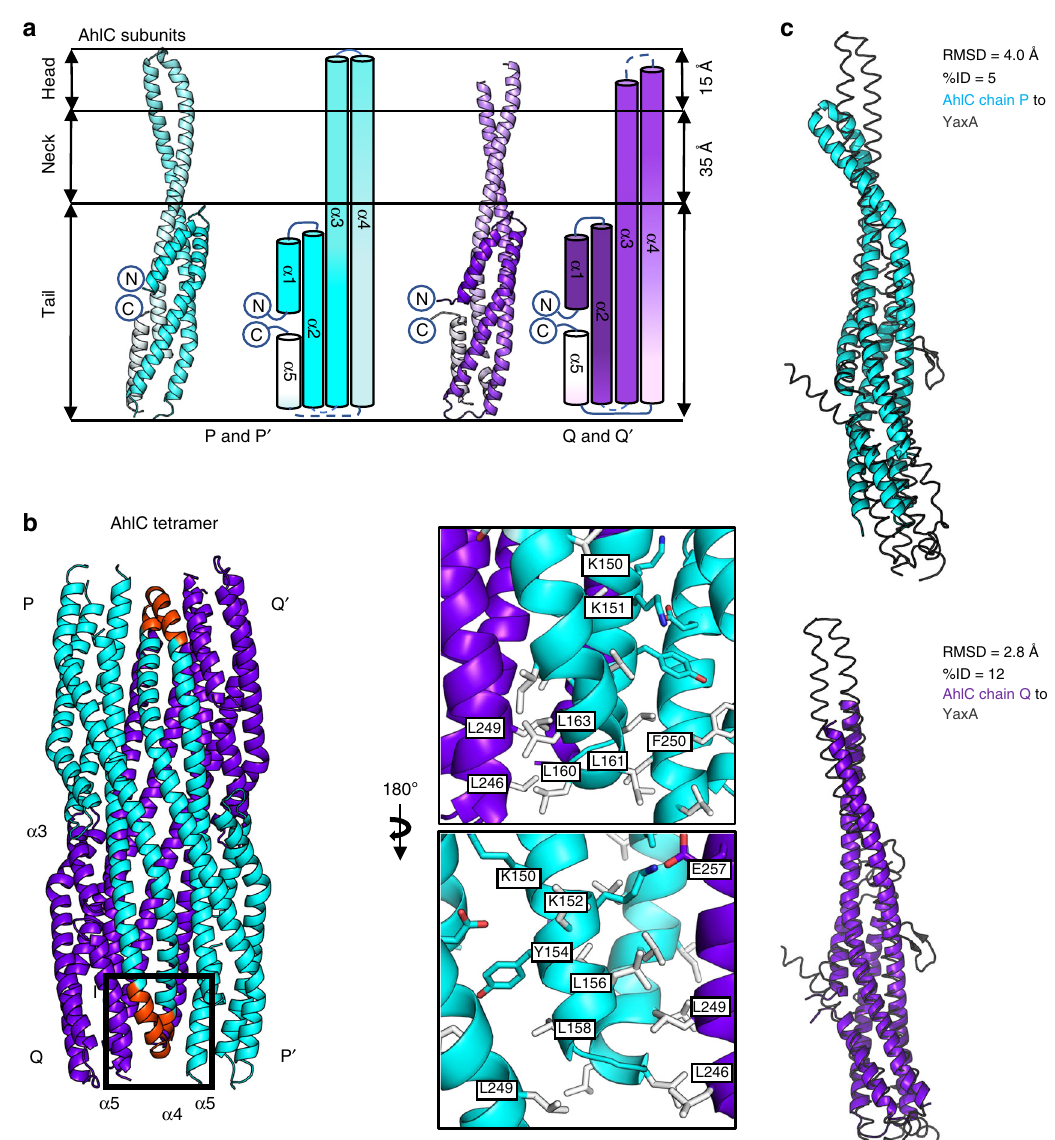
Fig. 5 The AhlC soluble tetramer buries its hydrophobic heads. a Cartoon and schematic structures of AhlC Form 1 subunits P and P ’ (cyan) and Q and Q ’ (purple), coloured dark (N-terminus) to light (C-terminus). b Tetrameric assembly of AhlC, hydrophobic heads of α 3 and α 4 are highlighted (red) in subunit P and form leucine zipper interactions with α 5 in the tails of both subunit Q and subunit P ’ . Hydrophobic residues are coloured white. c Superposition of YaxA (grey) with the two independent subunits of subunit P and Q of the AhlC tetramer, as aligned by the DALI server 59 , showing higher structural similarity to subunit